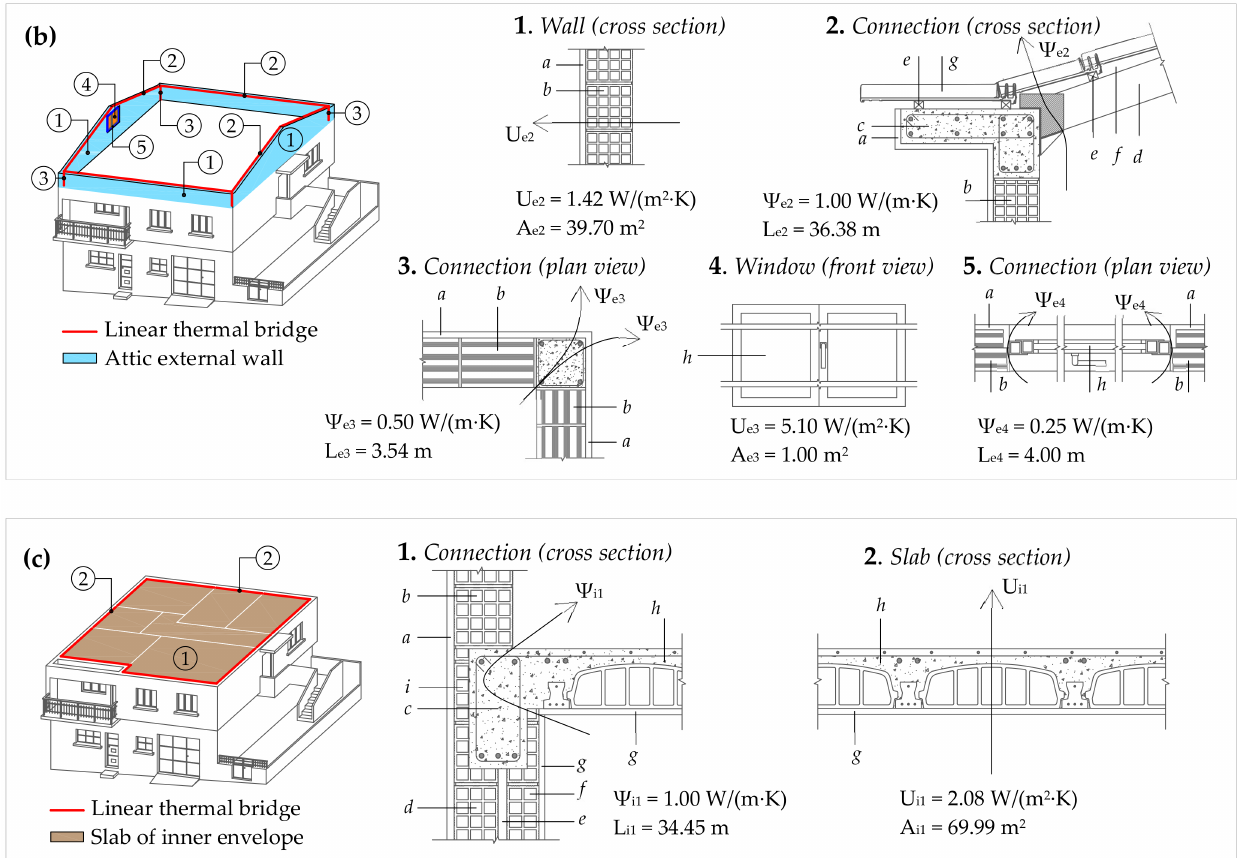
Figure 5. Characterization of the thermal envelope of Attic 2: ( a ) sloping roof slab separating the UnSp from the EXT: Note 1: No scale Note 2: (a) wooden beams (8 × 16 cm 2 cross section); (b) timber sleepers (5 × 7 cm 2 cross section); (c) ceramic roof tiles; (d) highly ventilated space, due to the lack of a continuous coating under the roof tile; (e) reinforced concrete beam.( b ) walls and window separating the UnSp from the EXT: Note 1: No scale; Note 2: (a) traditional rendering mortar (2.5 cm) with λ = 1.8 W/(m · K); (b) hollow clay brick (20 cm) with R = 0.52 m 2 · K/W; (c) reinforced concrete; (d) wooden beams (8 × 16 cm 2 cross section); (e) timber sleepers (5 × 7 cm 2 cross section); (f) space immediately below the ceramic tiles is considered strongly ventilated; (g) ceramic roof tile; (h) window of wooden frames, simple glass. ( c ) the horizontal slab that separates the INT from the UnSp: Note 1: No scale; Note 2: (a) traditional rendering mortar (2.5 cm) with λ = 1.8 W/(m · K); (b) hollow clay brick (20 cm) with R = 0.52 m 2 · K/W; (c) reinforced concrete; (d) hollow clay brick (15 cm) with R = 0.39 m 2 · K/W; (e) non-ventilated air gap (3 cm) with R = 0.18 m 2 · K/W; (f) hollow clay brick (11 cm) with R = 0.27 m 2 · K/W; (g) traditional rendering mortar (2.0 cm) with λ = 1.8 W/(m · K); (h) lightened slab with prefabricated pre-stressed concrete beams and ceramic vaults, a total of 19 cm thick (R asc = 0.27 m 2 · K/W); (i) hollow clay brick (4 cm) with R = 0.10 m 2 ·